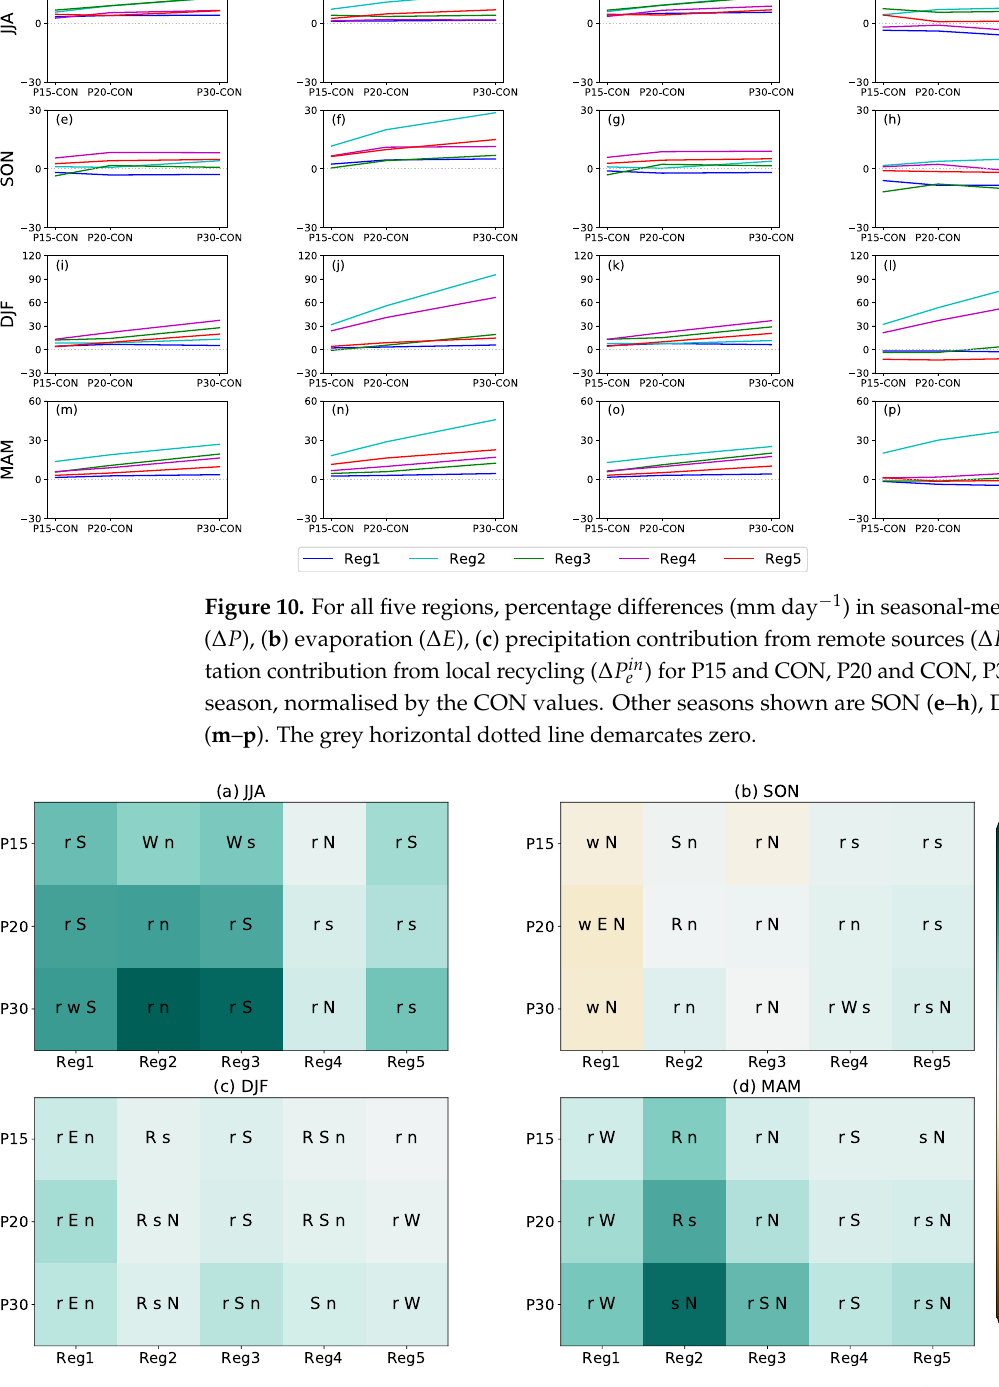
Figure 11. Seasonal mean differences in precipitation (shaded; mm day − 1 ) for each season, with the respective major changes in contributions to the mean precipitation over each region written as text. The contributions to the precipitation from moisture influx ( α ) are divided into those from the western (W), eastern (E), southern (S) and northern (N) boundaries of each region’s borders demarcated in Figure 1 and from precipitation recycling, R ( ρ ). The contributions to the precipitation are positive if the contribution’s letter is written in uppercase, and negative if it is written in lowercase. Only the contributions which are significant (with 70% ensemble member agreement on the sign of change) are shown here. Panels show seasons ( a ) JJA, ( b ) SON, ( c ) DJF, and ( d )